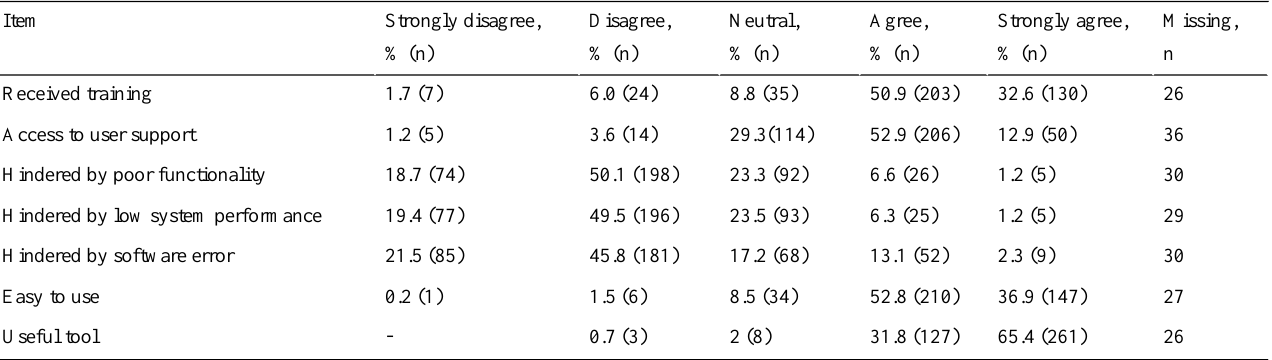
Table 2. Assessments of using e-messaging (N=425).